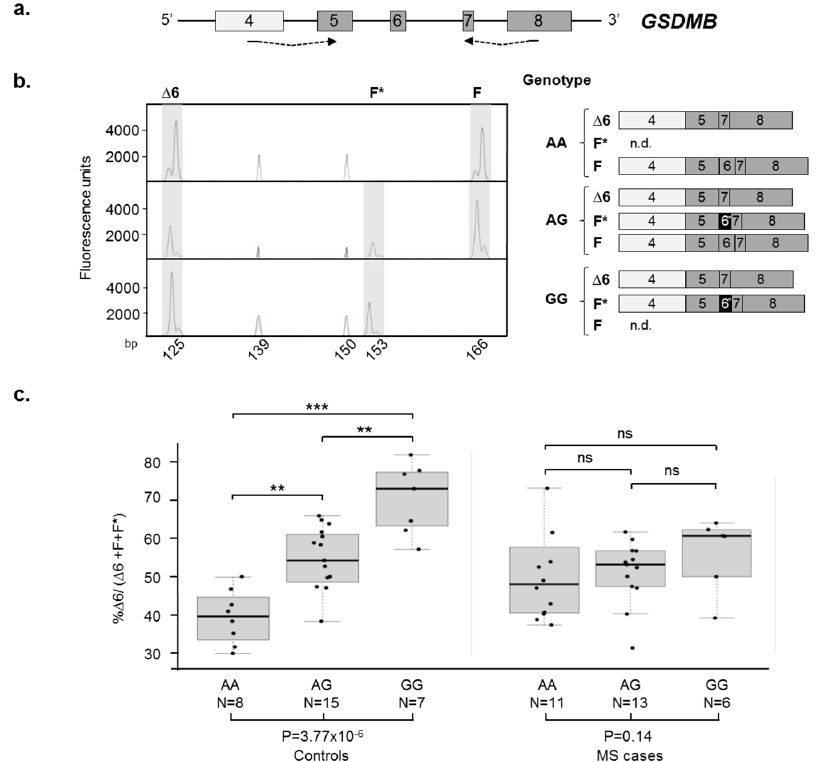
Figure 3. Analysis of exon 6/6* AS in multiple sclerosis (MS) cases and healthy controls. ( a ) Schematic representation of the GSDMB genomic region comprised between exons 4 and 8. Exons are approximately drawn to scale; alternative exons are depicted in dark grey, as in Figure 1. The dashed arrows below the scheme indicate the primer couple used in the fluorescent-competitive RT-PCR assay; the forward primer is labelled with the HEX fluorophore; ( b ) The left panel shows three GeneMapper windows, representing an example of the fluorescent products obtained for each of the rs11078928 genotypes. The peaks shaded in grey correspond to the RT-PCR products; those not shaded represent the size standard (ROX-500 HD). The schematic representation of the obtained products for each genotype is shown on the right. Exon 6* is depicted in black; ( c ) Boxplots showing the percentage of the Δ 6 isoform with respect to the sum of Δ 6, F*, and F isoforms measured on RNA extracted from 30 relapsing remitting (RR)-MS cases and 30 controls, grouped on the basis of the rs11078928 genotype. Boxes define the interquartile range; the thick line refers to the median. The number of subjects belonging to each group is also indicated (N). Significance levels of t -tests is shown above the boxplots (** p < 0.01; *** p < 0.001; ns: not significant). The one-way ANOVA p -values are reported below the boxplots.